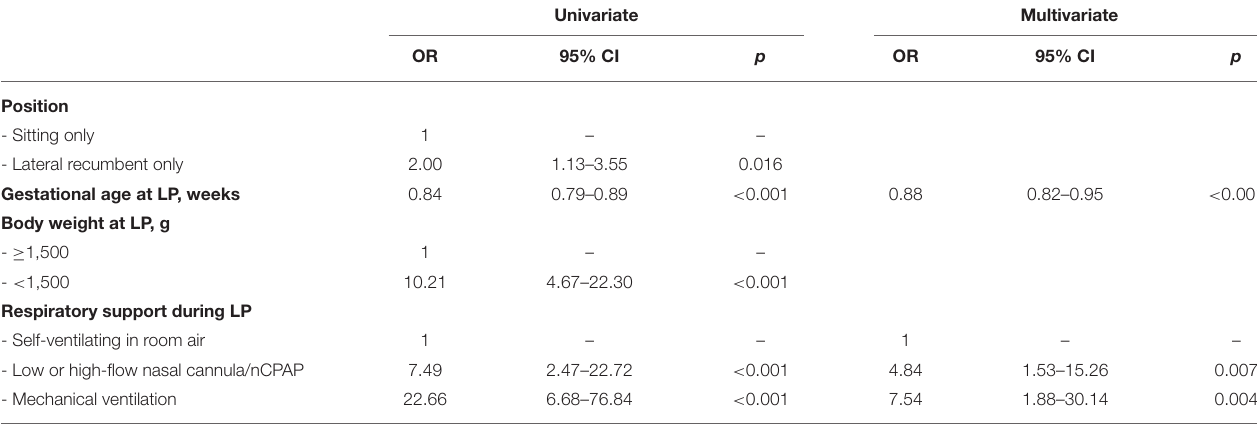
TABLE 3 | Univariate and multivariate analyses of factors associated with SpO 2 desaturations during lumbar puncture.